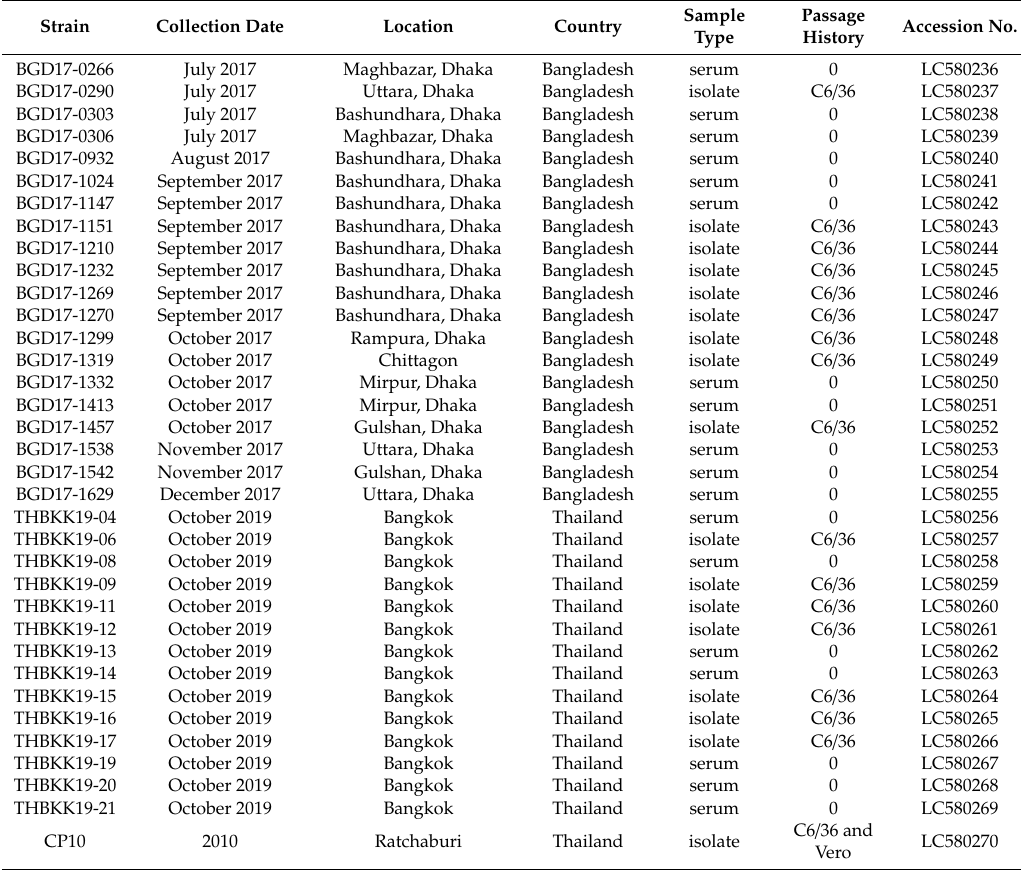
Table 1. CHIKVs in the present